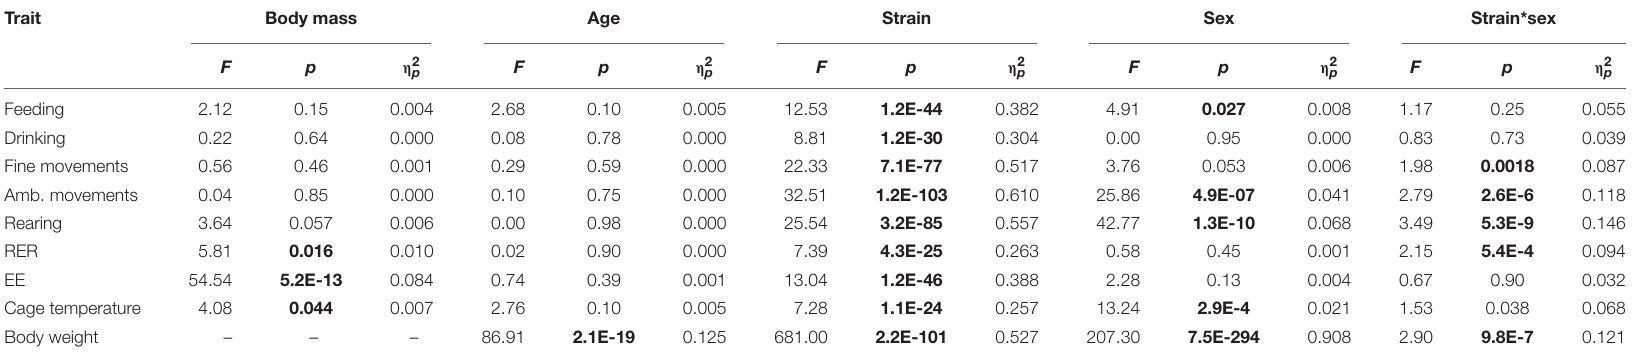
TABLE 2A | Influence of main factors strain and sex on the respective traits reported as F -values and partial Eta squared. Trait Body mass